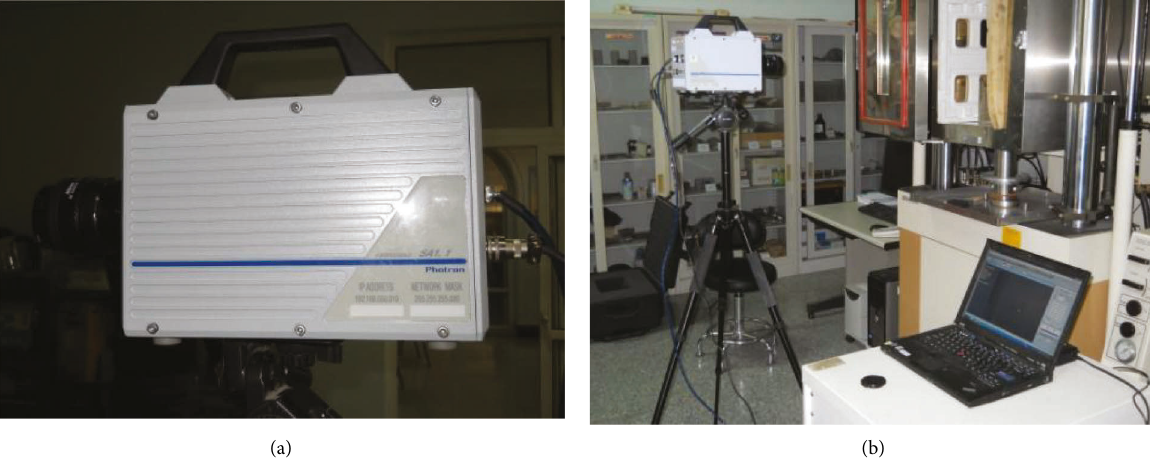
Figure 1: FASTCAM SA1.1 high-speed camera system: (a) FASTCAM SA1.1 high-speed camera and (b) information acquisition